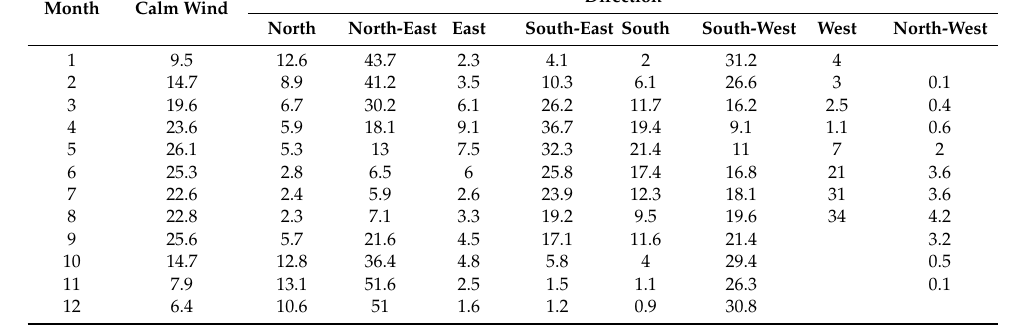
Table 1. The frequency and “calm wind” (%) based on directions at Quy Nhon station. Direction Month Calm Wind North North-East East South-East South South-West West North-West Table 2. The monthly average wind speed at Quy Nhon station from 2011–2016 (m/s). Month 1 2